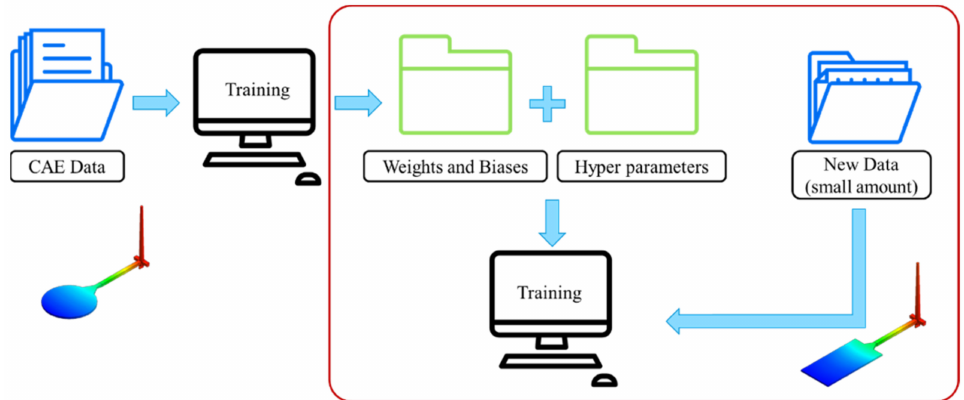
Figure 7. Transfer learning process between different